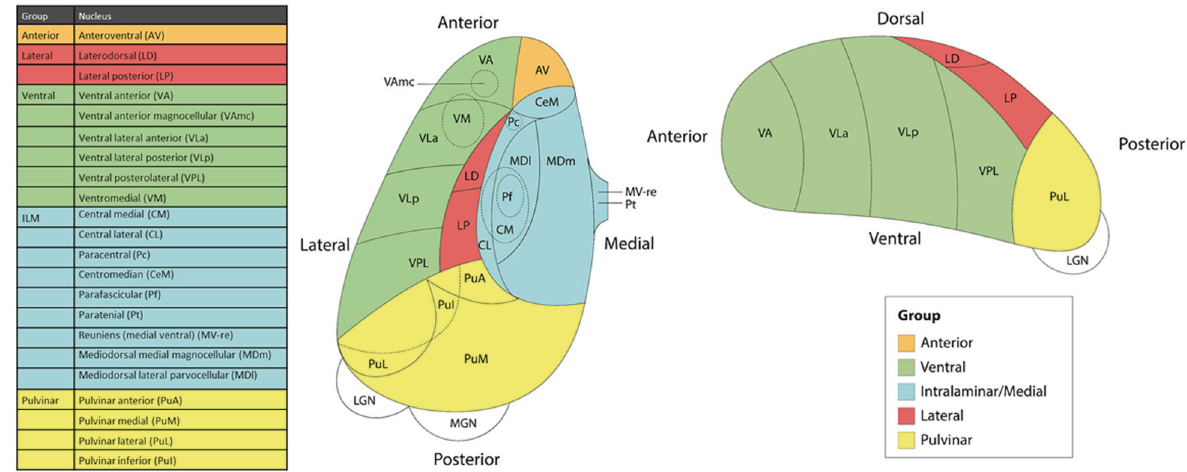
Fig. 1 Schematic representation of thalamic nuclei grouping. Figure adapted from Thalamic Subregions and Obsessive-Compulsive Symptoms in 2500 Children From the General Population by Weeland et al., 2021, Journal of the American Academy of Child and Adolescent Psychiatry